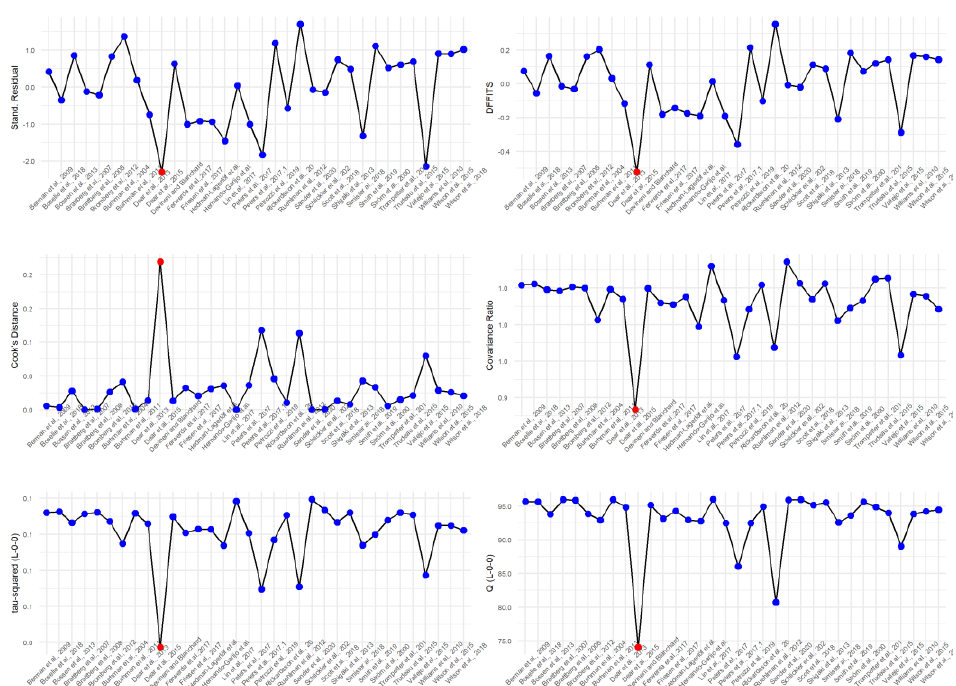
Figure A4. Influence analyses of all the studies.